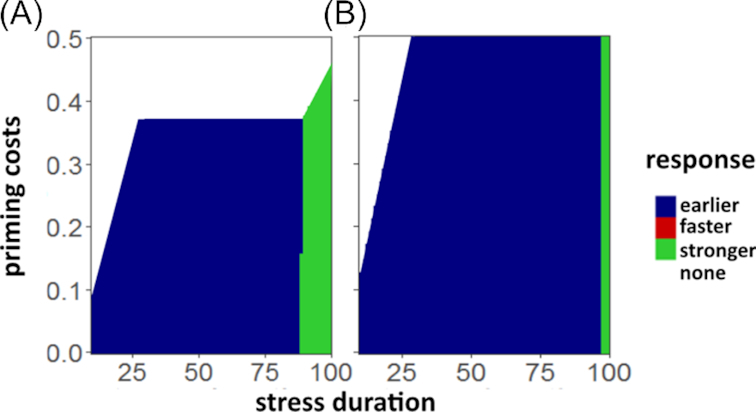
Most beneficial primed response under competition dependent on stress duration and priming costs. Results are given for (A) medium competition intensity (\documentclass[12pt]{minimal}
\usepackage{amsmath}
\usepackage{wasysym}
\usepackage{amsfonts}
\usepackage{amssymb}
\usepackage{amsbsy}
\usepackage{upgreek}
\usepackage{mathrsfs}
\setlength{\oddsidemargin}{-69pt}
\begin{document}
}{}${\rm{\alpha \ }} = {\rm{\ }}0.5$\end{document}) and (B) high competition intensity (\documentclass[12pt]{minimal}
\usepackage{amsmath}
\usepackage{wasysym}
\usepackage{amsfonts}
\usepackage{amssymb}
\usepackage{amsbsy}
\usepackage{upgreek}
\usepackage{mathrsfs}
\setlength{\oddsidemargin}{-69pt}
\begin{document}
}{}${\rm{\alpha \ }} = {\rm{\ }}1$\end{document}).